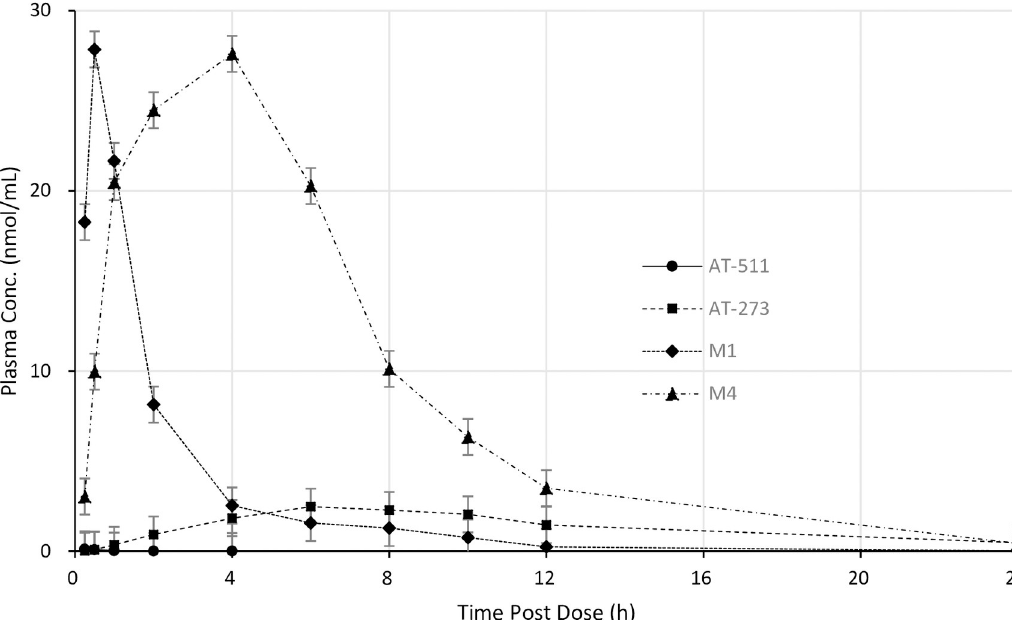
Fig 6. Mean profiles of AT-511 and its metabolites in rat plasma over 24 h. Sprague-Dawley rats (3 male and 3 female) were administered a 300 mg/kg single oral dose of AT-527 and plasma concentrations of AT-511, AT-273, M1 and M4 were measured by LC-MS/MS. Data are mean ± SD of all 6